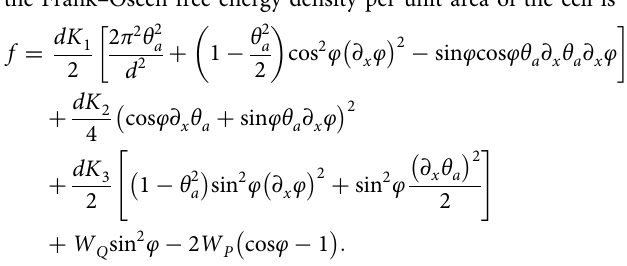
Fig. 8 Simulated ππ soliton-soliton domain walls with non-zero polar tilt. a Tilt magnitude θ a ( x ) and polar angle φ ( x ) pro fi les calculated by numerical minimization of the Frank – Oseen energy in Eq. (4) using the ansatz in Eq. (3) for K 1 / K 3 = 10. The largest tilt occurs near φ ¼ π intensity through a cell and a fi lter of the type shown in Fig. 4e, where the wavelength λ of light is chosen such that π d 4 n comparison between these results and the experimental data in Fig. 4c, f. Transmission is strong whenever φ ¼ π the polarization fi eld in the one-quarter of the ππ -soliton in which we fi nd the largest tilt θ , with the same parameters as in ( a ). In all simulations, d = 15 ξ 3 , K = K ω = 2 3 /2, and